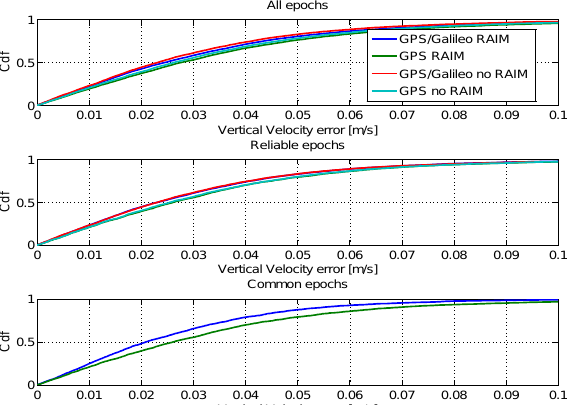
Figure 20. CDFs of the vertical velocity errors. Upper box: CDFs computed using all available epochs; central box: CDFs computed using only reliable epochs; lower box: CDFs computed using only reliable common epochs.